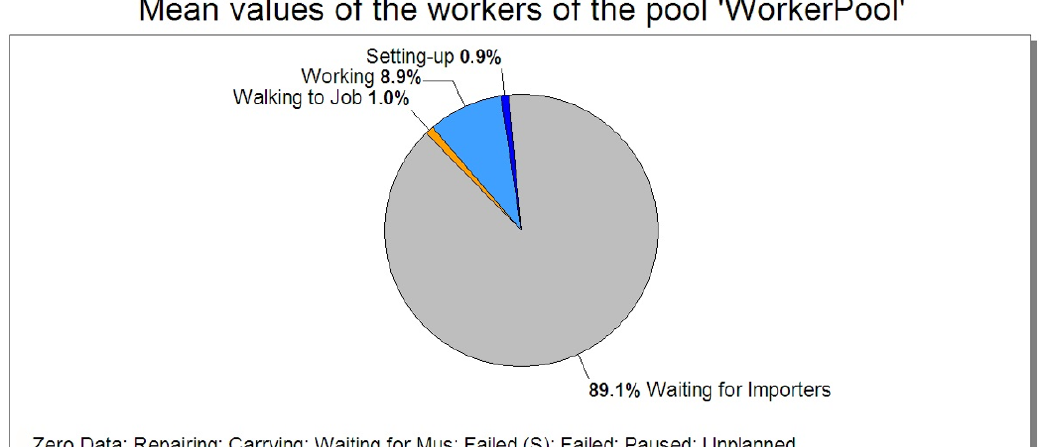
Figure 7. Percentage distribution of controller activities during the production process.